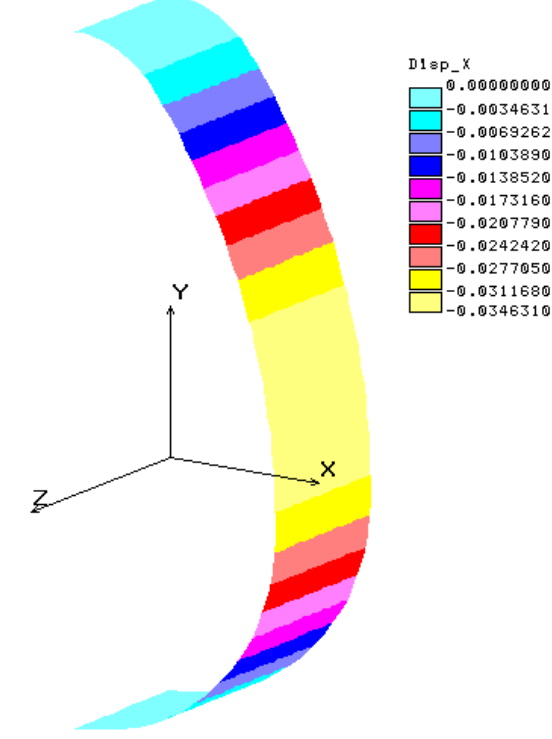
Figure 8: Diagram of horizontal displacements, wall thickness equal to 12 mm, load scheme